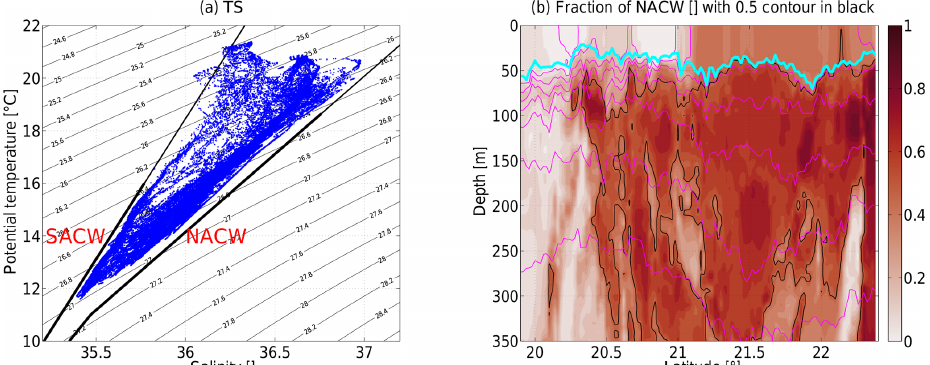
Figure 5. (a) Temperature–salinity diagram of all measured CTD data with the fresher South Atlantic Central Water (SACW) and the saltier North Atlantic Central Water (NACW) end-member lines according to Tomczak (1981) marked in black. (b) Section of warm, salty North Atlantic Central Water (NACW) end-member fraction for an isopycnal decomposition between SACW and NACW. The 0.5 contour is indicated in black. The mixed layer depth and isopycnals are as in Fig.